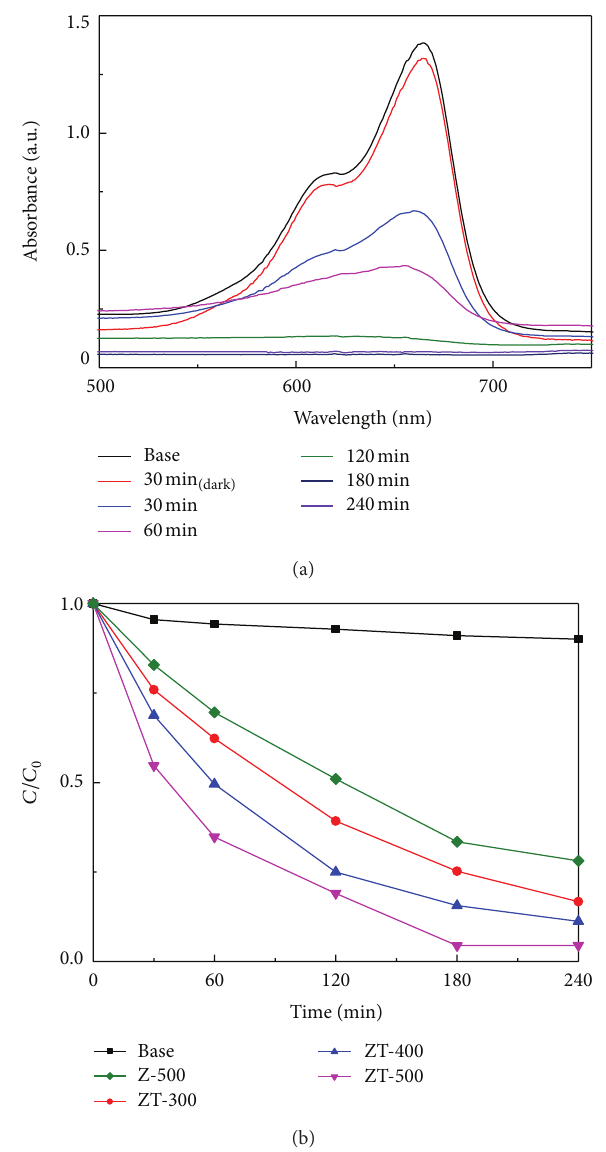
Figure 5: (a) UV-vis absorbance spectra of MB for the ZT-500. (b) Photodegradation of the MB for ZT-300, ZT-400, ZT-500, and Z- 500.